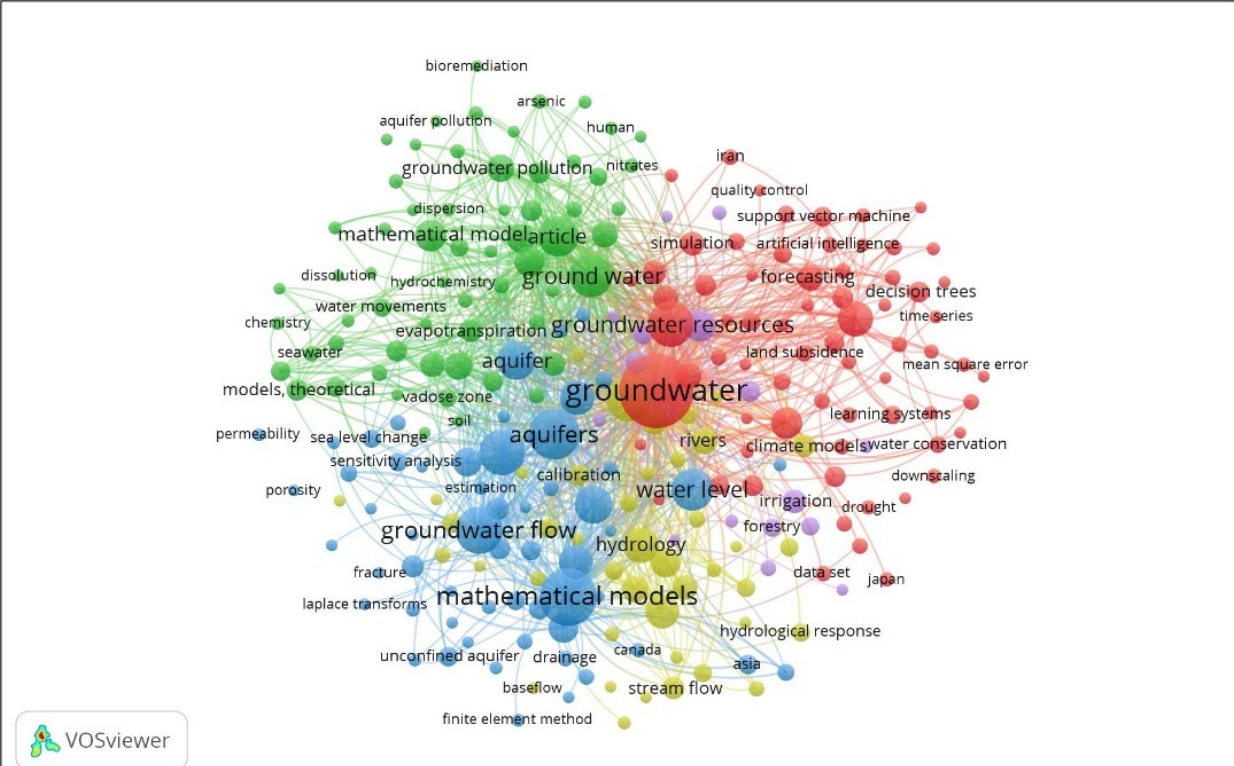
Figure 13. Co-occurrence of author keywords with overlay visualization.